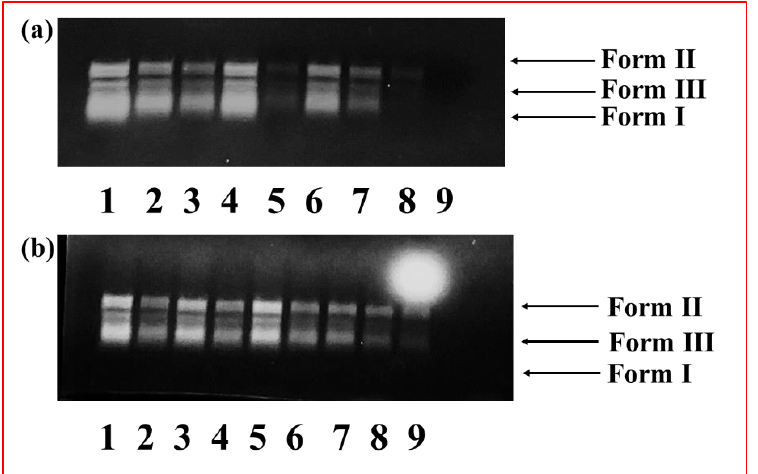
Figure 11. Plasmid DNA cleavage activity of ( a ) GO-NCD- 1 and ( b ) GO-NCD- 2 at different concentrations, 2.5 μM to 20 μM (lane 2 to 9) (Lane 1 = DNA control).